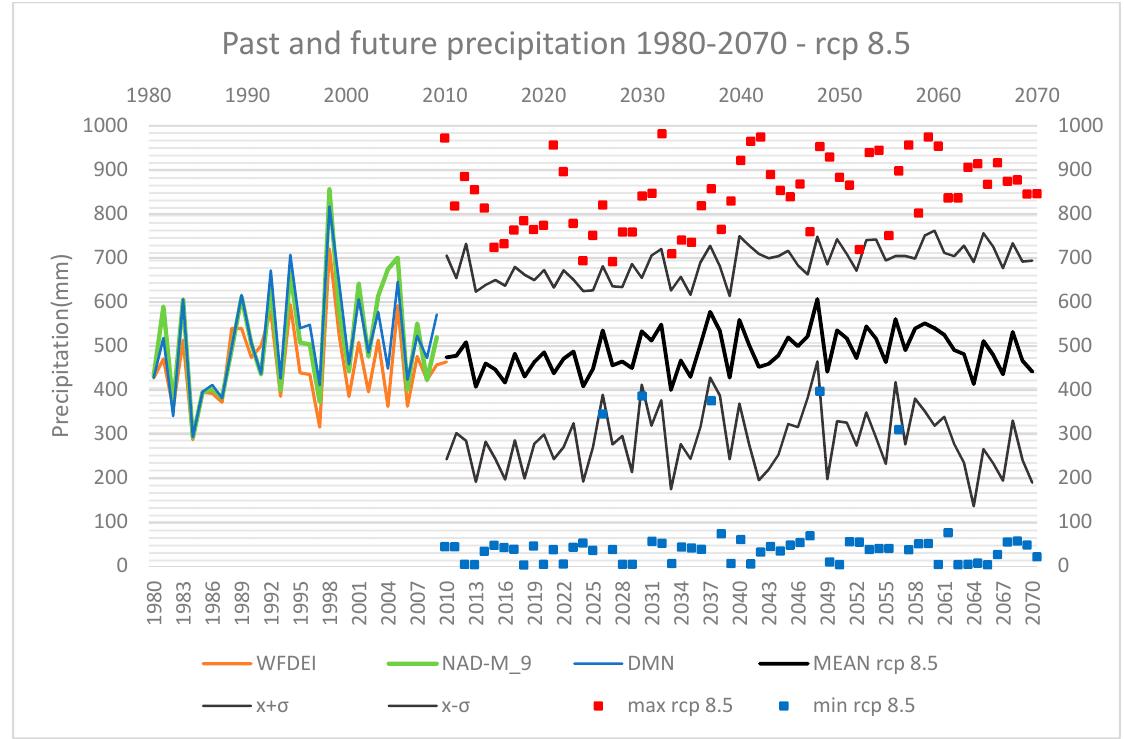
Figure 9 . Past and future precipitation 1980–2070—rcp 8.5. Figure 9. Past and future precipitation 1980–2070—rcp